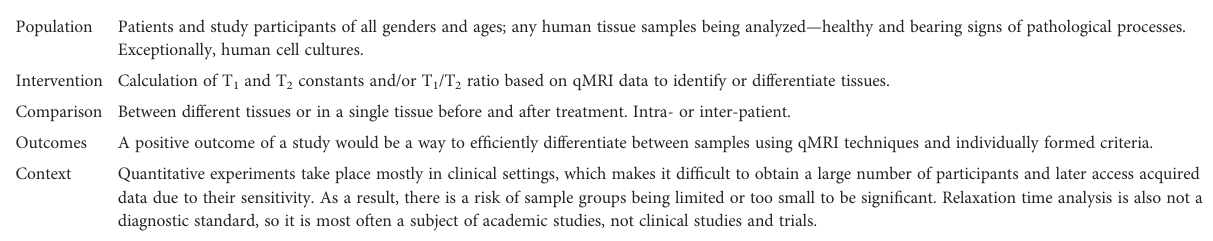
TABLE 1 Review questions in light of the PICOC scheme.